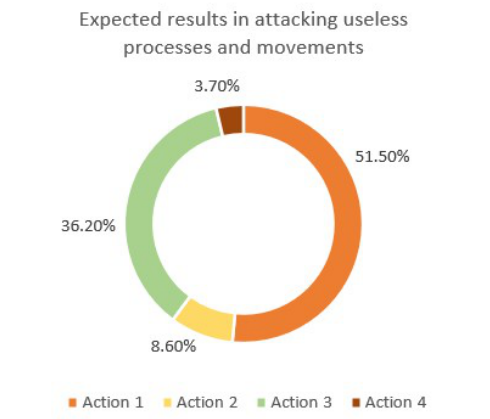
Figure 8. Expected impact of the four designed actions.